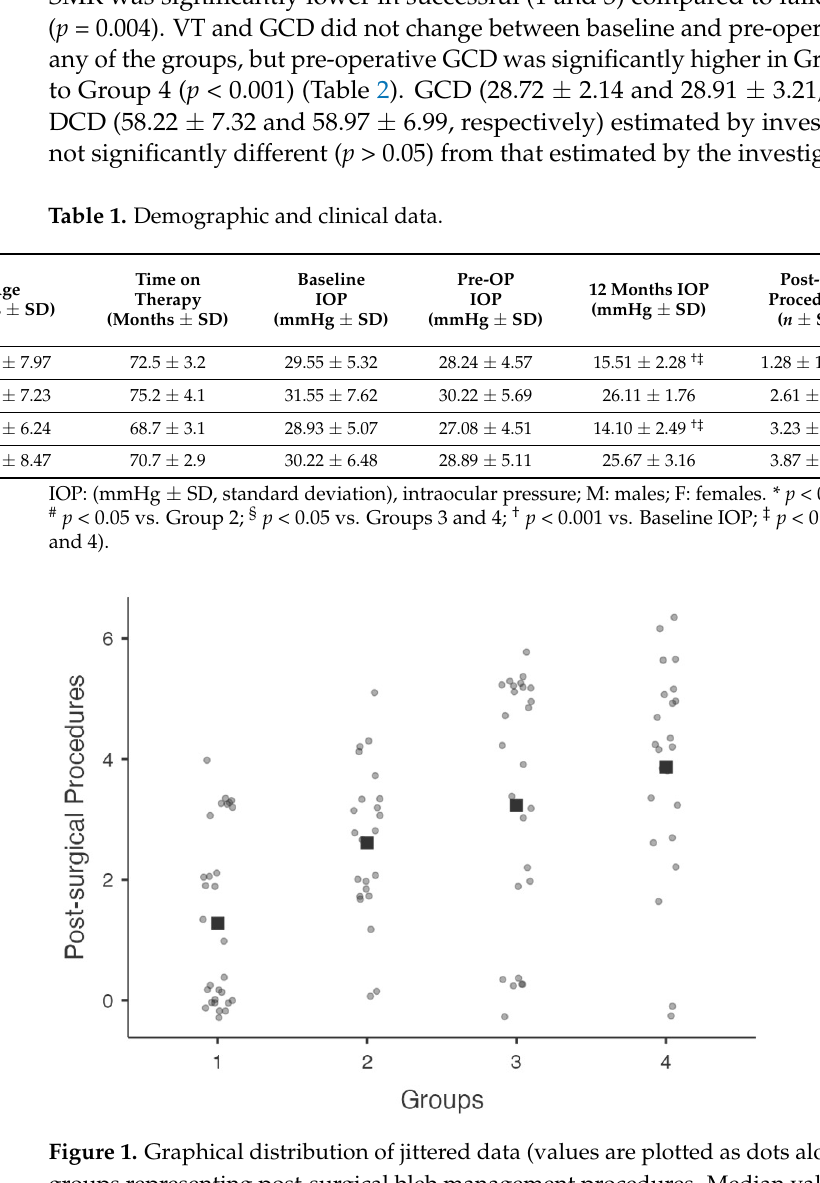
Table 1. Demographic and clinical data.